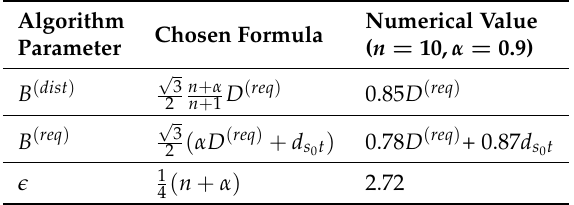
Table 7. Numerical example for applying Theorem 1 for greedy algorithm